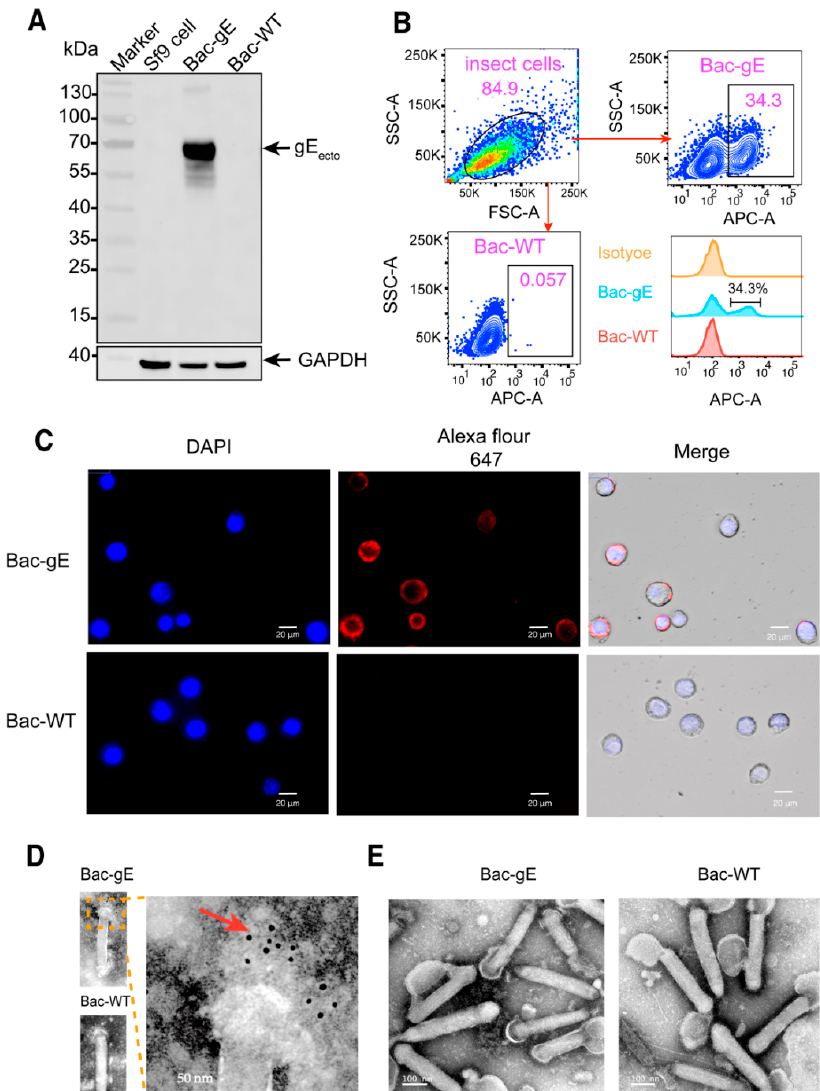
Figure 2. Characterization and generation of the displayed gE proteins. ( A ) Western blot analysis of gE protein expression by Sf9 cells infected with the recombinant baculovirus (Bac–gE, or Bac–WT as a control). Protein was detected using the anti-His primary antibody and repeated twice. ( B ) Frequency of gE expression in cells by flow cytometry analysis. Positive signals indicate successful display of the gE protein on the cell membrane. Three experiments were conducted, and the data presented represent the results from one independent infection experiment. ( C ) Immunofluorescence assay for the expression of gE proteins in Sf9 cells. Sf9 cells were infected with Bac–gE and Bac–WT and then fixed, stained, and analyzed using fluorescence microscopy (bar = 20 µ m). Red fluorescence suggests the expression of gE. Blue fluorescence (DAPI) staining is used to indicate the location of the nucleus. ( D ) Electron micrographs of immunogold-labeled rBV Bac–gE. Positive colloid gold signals indicated by the red arrow showed that VZV gE proteins are displayed on the surface of the recombinant baculovirus. (bar = 50 nm). ( E ) Electron microscopic images of negatively stained wild-type and gE baculovirus particles (bar = 100 nm). Transmission electron microscopy experiments were conducted twice. The data presented are from one representative